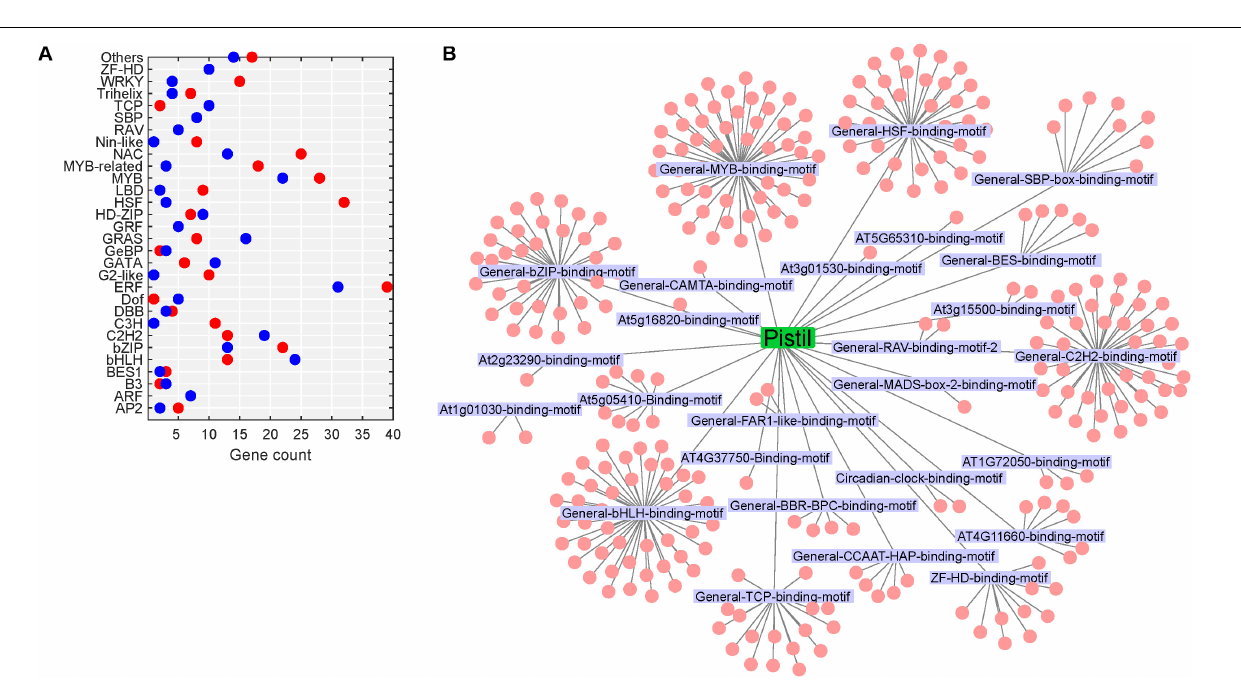
FIGURE 10 | Heat stress-regulated transcriptional cascade in the pistil. (A) TFs belonging to different TF gene families differentially regulated in heat-stressed pistil; red dot represents upregulated TFs, and the blue dot represents downregulated genes. (B) Network of enriched TFs and the motifs present in the promoters of heat-responsive genes in heat-stressed pistil; the motifs are labeled, and the cluster associated with a motif represents the TFs.